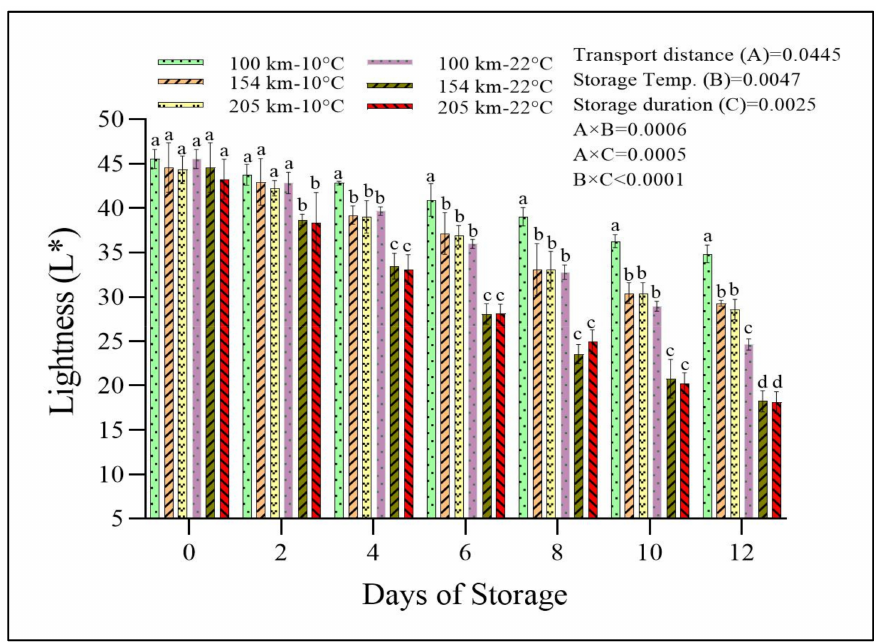
Figure 5. L* value of tomatoes from three different distances stored at (A) 10 ± 0.5 ◦ C (95 ± 1% RH) and (B) 22 ± 1 ◦ C (65 ± 5% RH) for 12 days. Error bars represent standard error (SE) of the mean values ± S.E. of 25 measurements (readings) of 5 tomato replicates. Bars with different letters (per day) are significantly different ( p < 0.05) performed by the Tukey HSD test and numerical values of A, B, and C are p